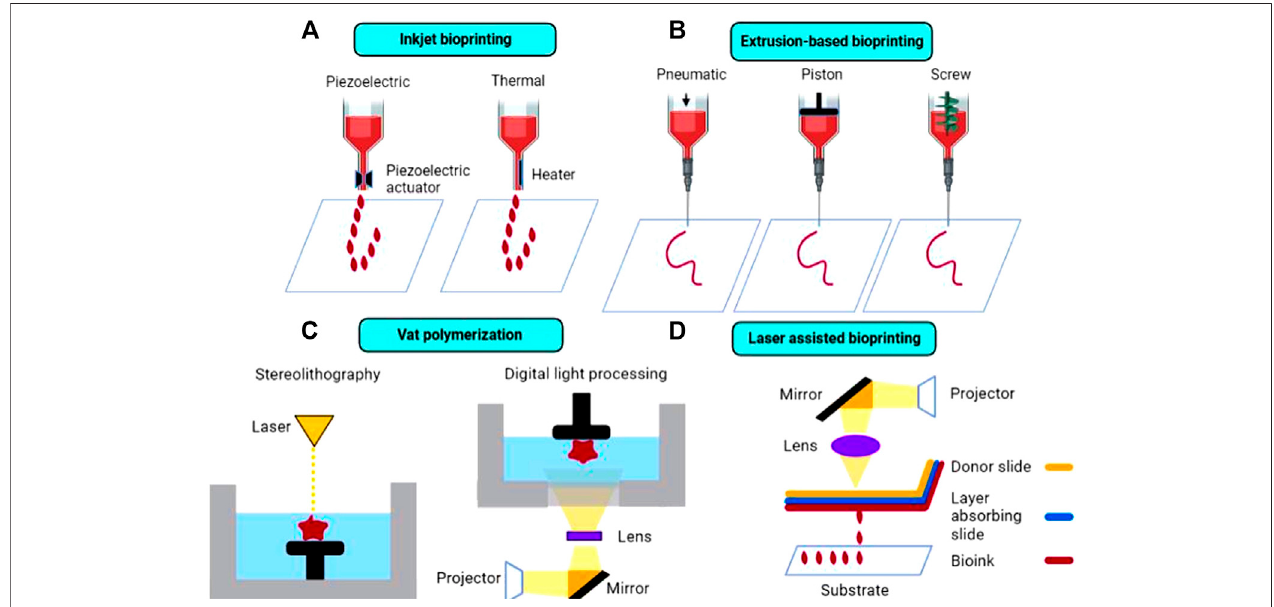
FIGURE 3| Schematic diagram of the most common 3D bioprinting techniques in cartilage tissueengineering, including (A) inkjet bioprinting, (B) extrusion-based bioprinting, (C) vat polymerization, and (D) laser-assisted bioprinting.